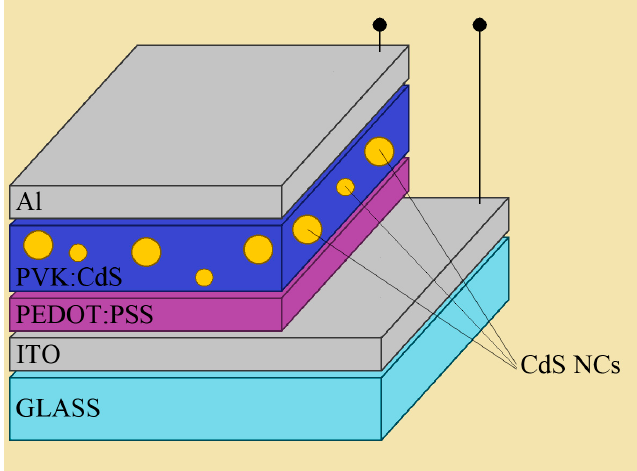
Figure 3. Schematic structure of hybrid LED with PVK:CdS active layer.